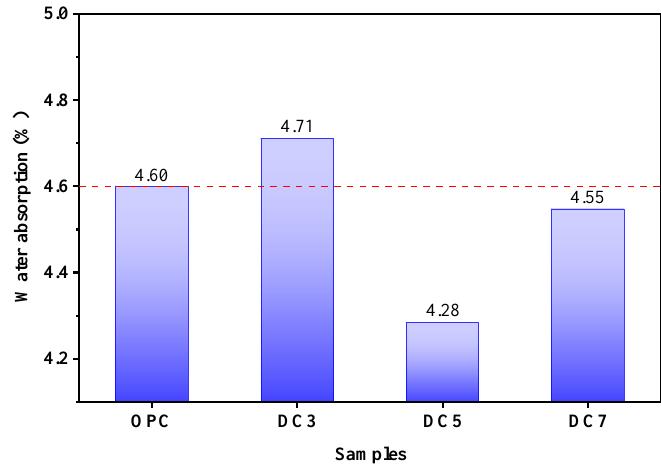
Figure 8. Slumps of samples.